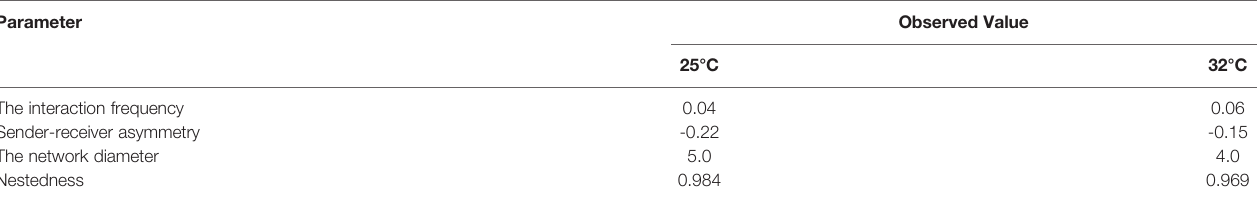
TABLE 2 | Antagonism network parameters under different